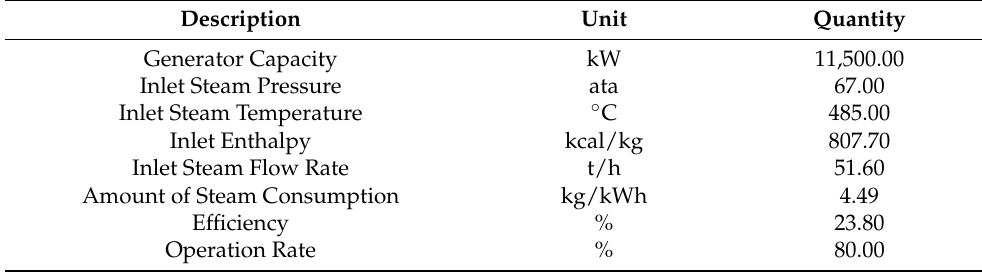
Table 3. The LCOE of trading and purchasing of electricity in Cambodia.